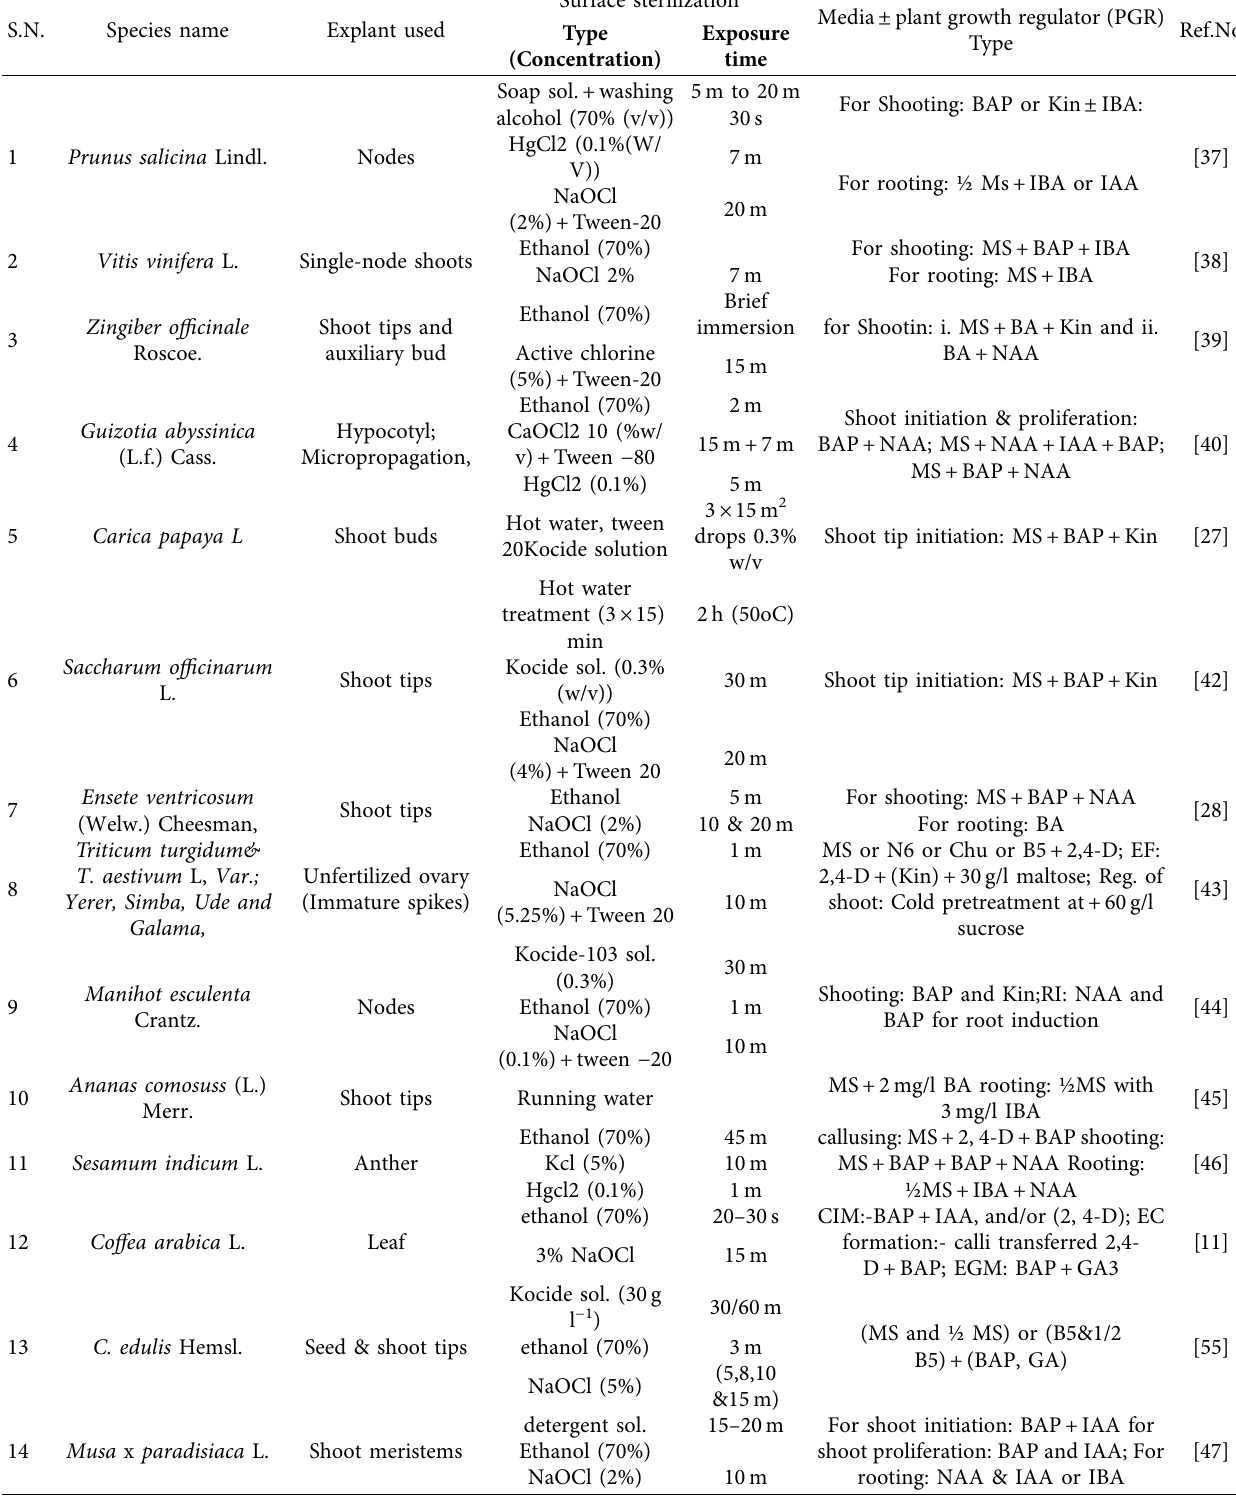
Table 2: List of species studied in Ethiopia, with background information on surface sterilization, plant growth regulators, and their applied